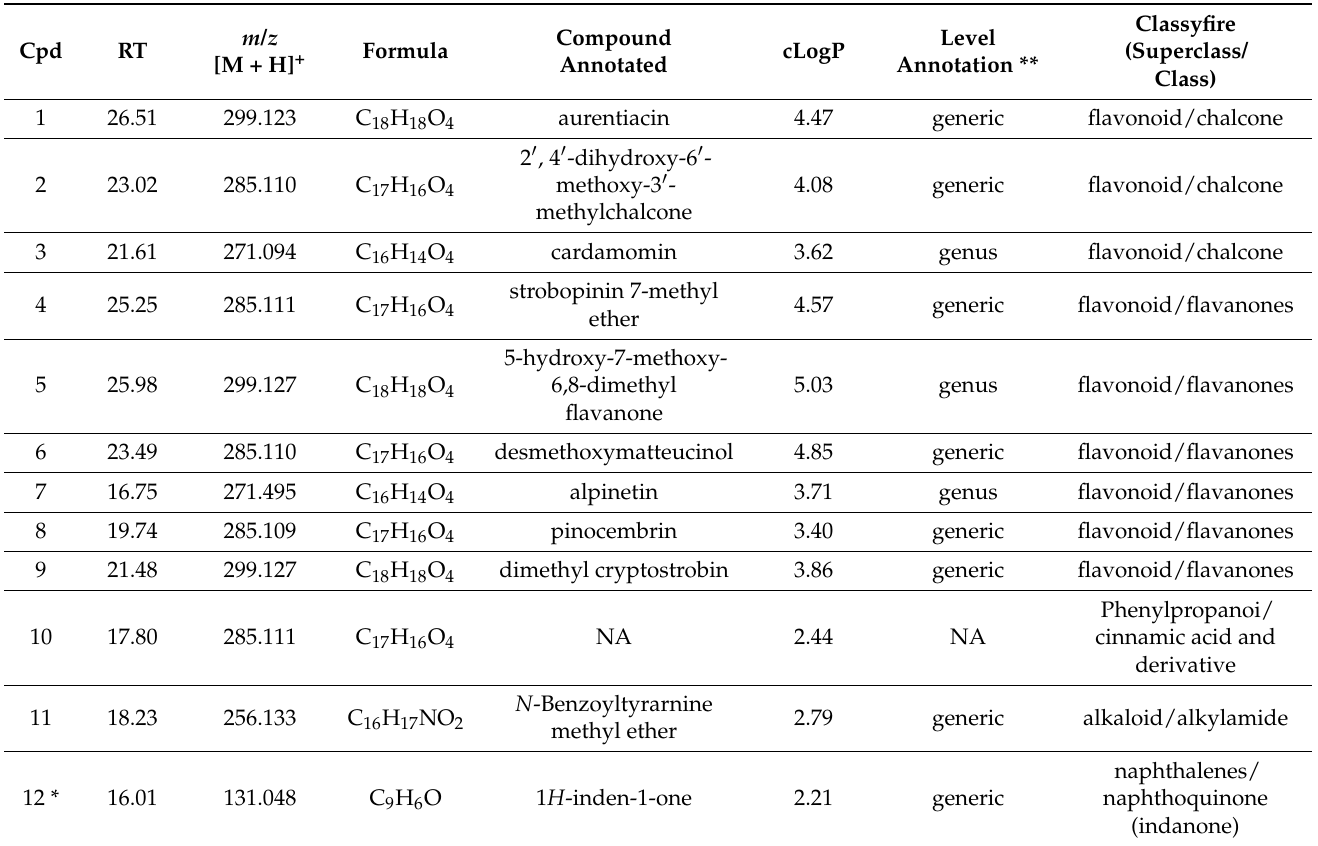
Table 1. Details on the annotation of targeted compounds. Using NPClassifire and ClassyFire [48,49], the major classes and subclasses of compounds following their biosynthetic pathway were identified. Cpd = compounds; NA = compounds not annotated; RT = retention time; * compound not targeted with the heme-binding assay; ** see Section